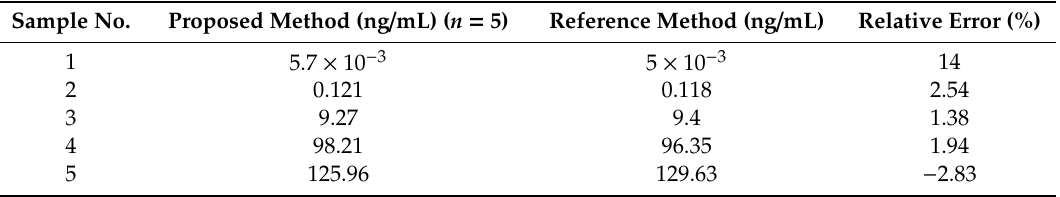
Table 2. Assay results of clinical serum samples using the proposed and reference methods. Sample